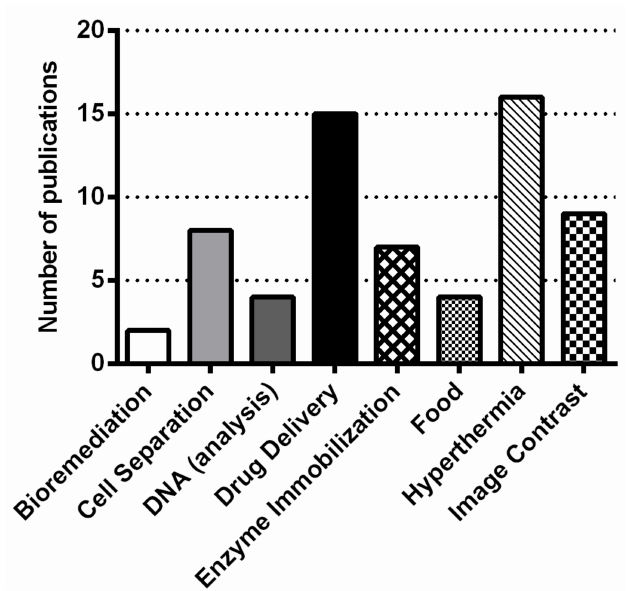
Figure 3. Total number of publications by application area. All scientific articles on databases [7,8] containing the keyword “magnetosome (s)” in article title were classified according to application area in Biotechnology (bioremediation, cell separation, DNA analysis, drug delivery, enzyme immobilization, food, hyperthermia, image contrast). For analysis of raw data, see Table S1. The criteria used for selection of these data are detailed in “Database generation & analysis